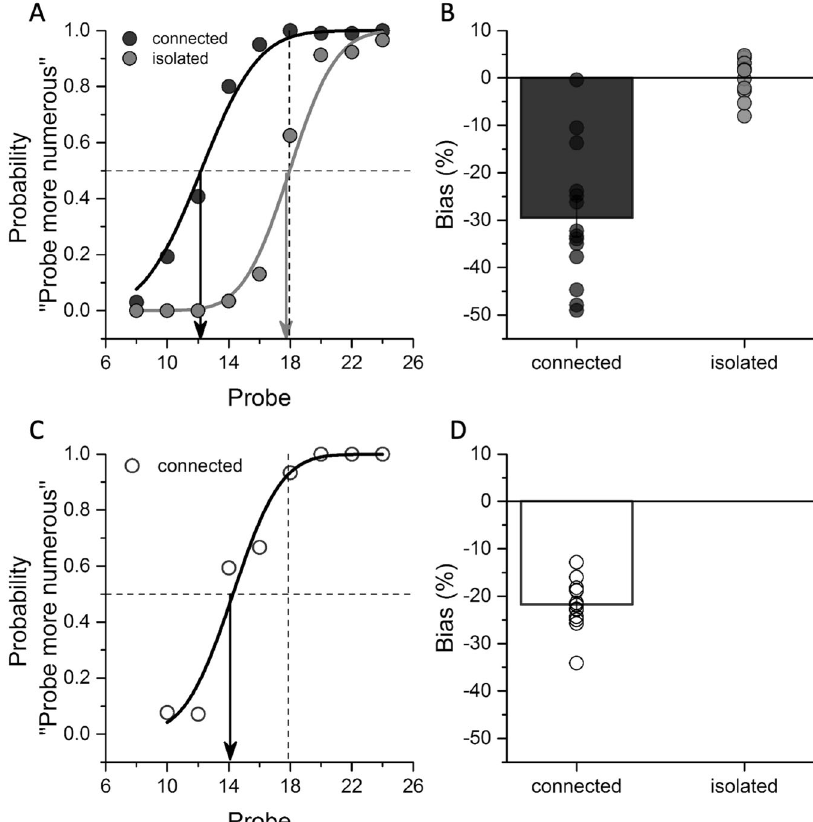
Fig. 2 Psychophysics results. A Typical psychometric curves for one participant, measuring the connectedness effect on perceived numerosity for experiment 1. The proportion of trials in which the probe pattern was reported to be more numerous than the standard (which comprised 18 isolated dots) is plotted as a function of the number of dots in the probe pattern. Black and gray lines refer to the connected and isolated conditions, respectively. Arrows indicate the PSE measured in the two conditions. Leftward shifts of the psychometric curve imply underestimation of the test arrays. B Perceptual bias expressed as percentage of PSE difference from the reference numerosity for the two connectedness conditions. Bars represent average across participants ( N = 14 participants, individual data reported as black and gray circles for the connected and isolated conditions, respectively), error bars show 1 SEM. C , D Example psychometric curve and average perceptual bias measuring the connectedness effect on perceived numerosity for experiment 2 ( N = 13 participants, open circles). Bars represent average across participants and error bars show 1 SEM. The results from the fi rst experiment ( A , B ) were replicated in the second one ( C , D ). Source data are provided as a Source Data fi